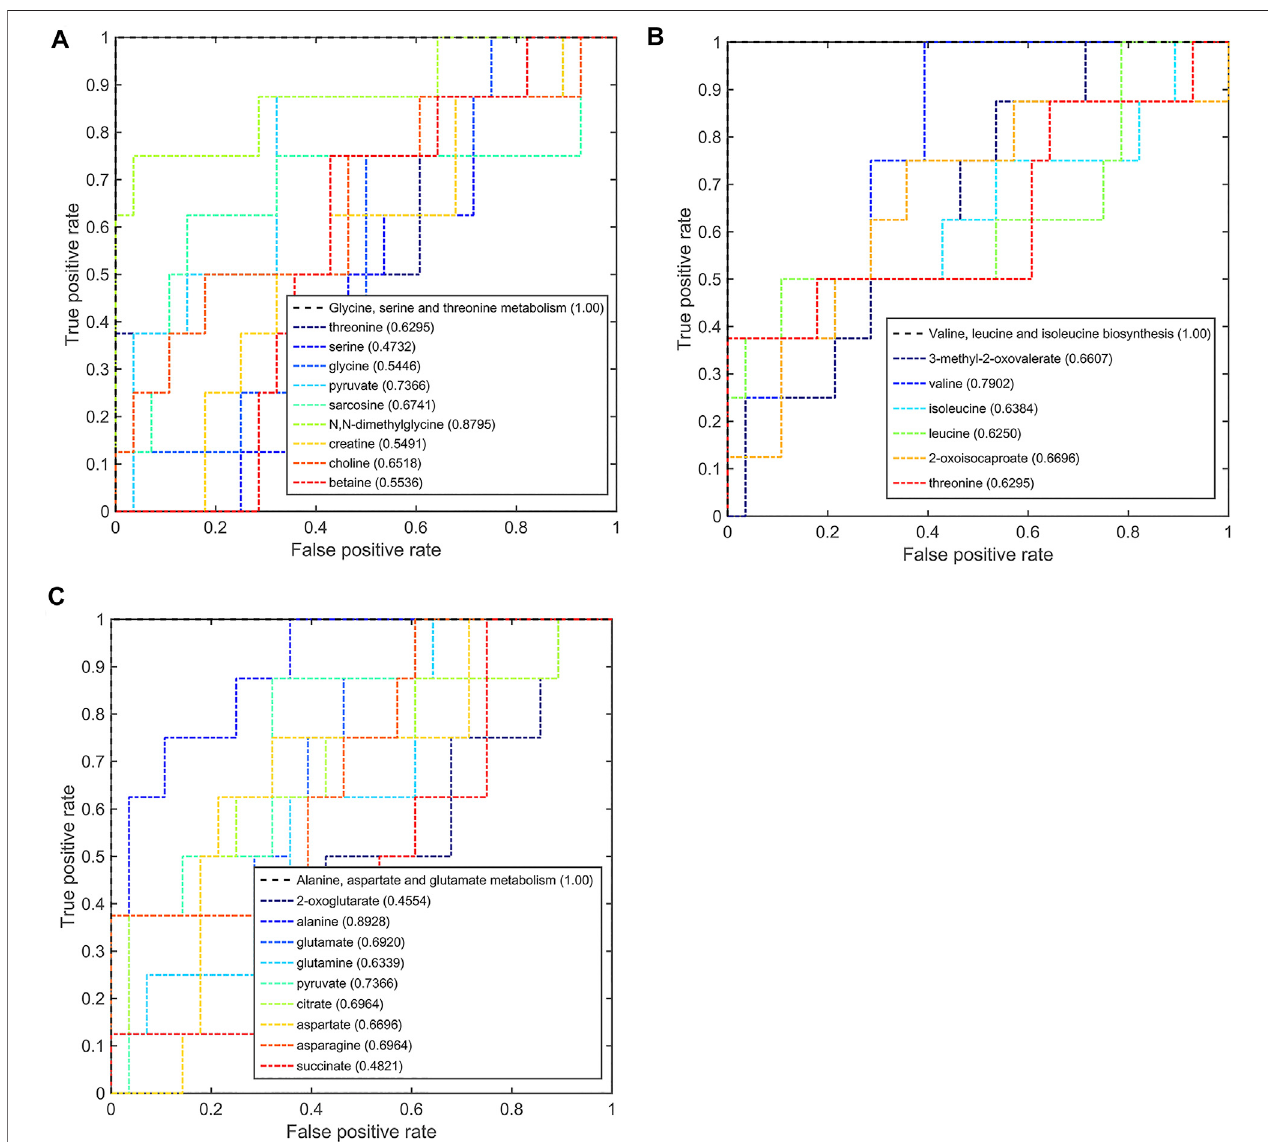
FIGURE 8 | Multi-ROC curves assessing discriminant capabilities of the signi fi cantly disturbed metabolic pathways in the pCR patients compared with the pPR patients. The AUC values shown in brackets are used to evaluate the performances of various biomarker models: (A) glycine, serine, and threonine metabolism; (B) valine, leucine, and isoleucine biosynthesis; (C) alanine, aspartate, and glutamate metabolism.